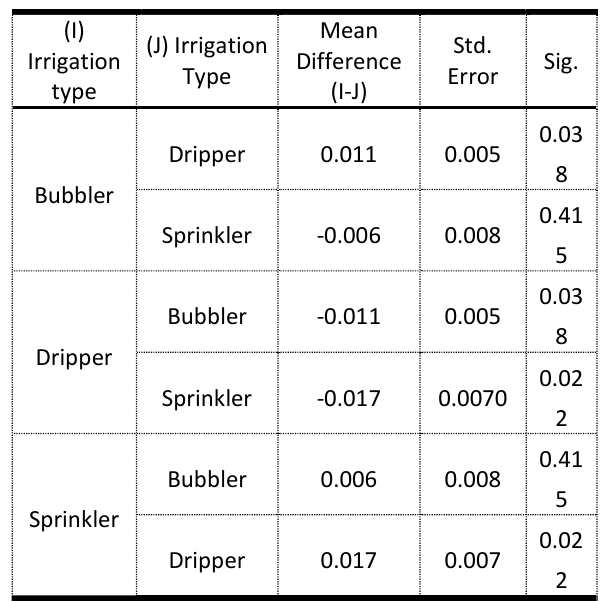
Table 6: Summary of Post Hoc Pairwise